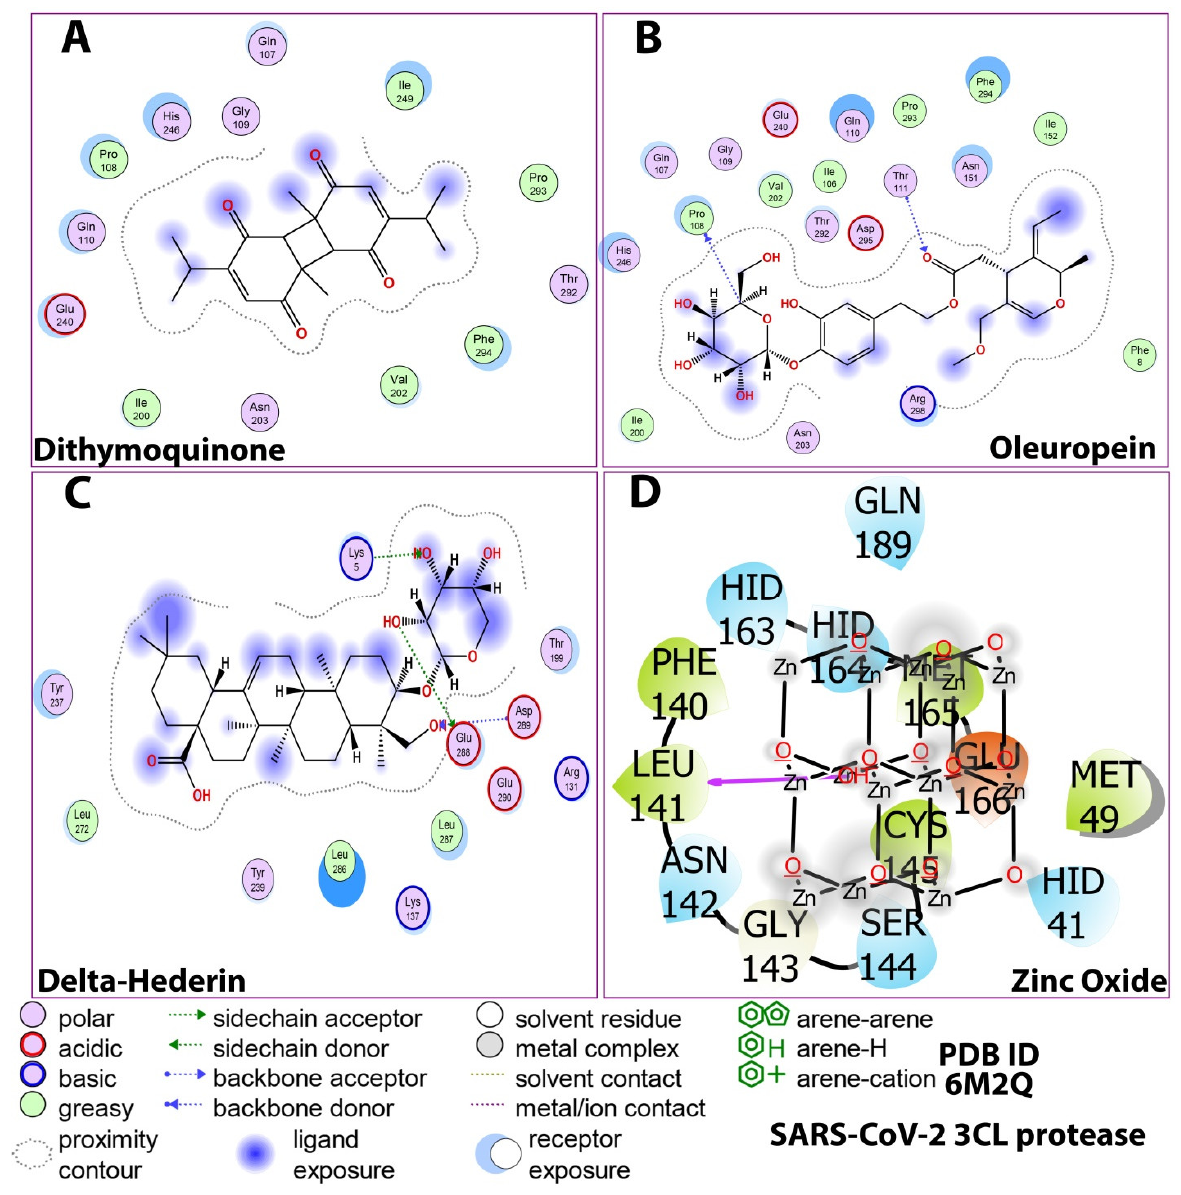
Figure 4. Post-docking compound–protein interaction map displayed in 2D showing the nature of molecular interaction between the ligands and the protein. ( A ) dithymoquinone, ( B ) oleuropein, ( C ) delta-hederin (δ-hederin), ( D ) zinc oxide.